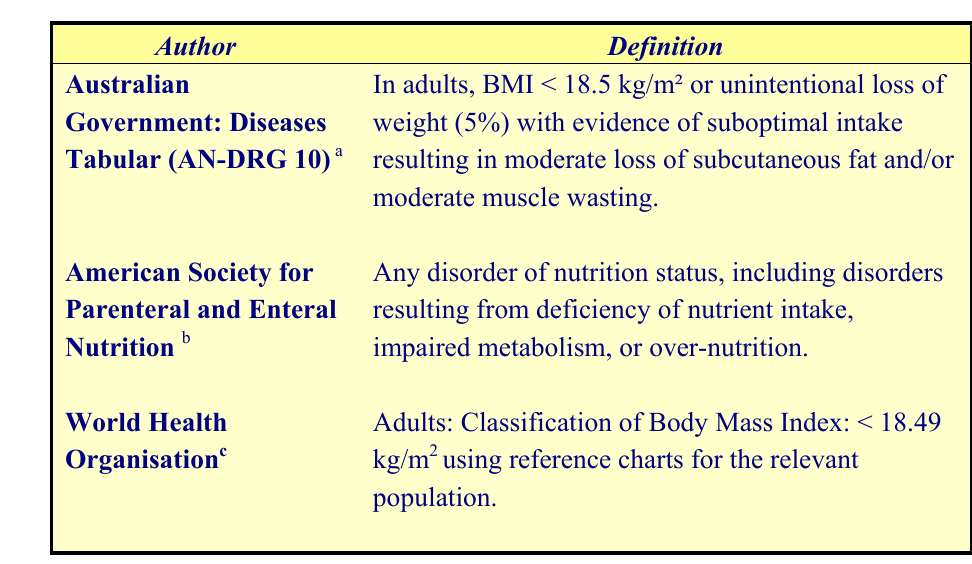
Table 1. Definitions of